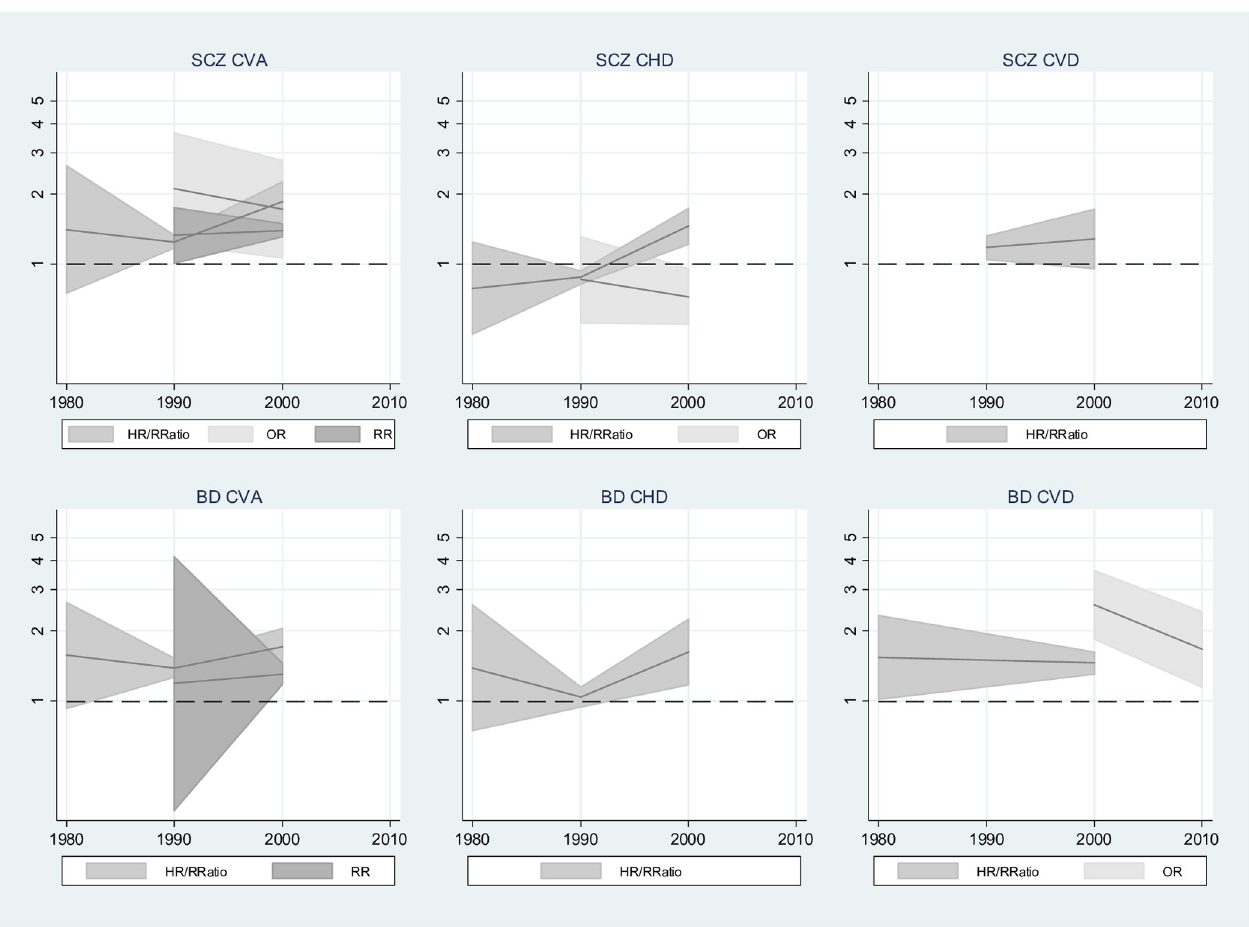
Fig 5. Trend in risk of CVD incidence for SMI compared with control participants, by median decade. BD, bipolar disorder; CHD, coronary heart disease; CI, confidence interval; CVA, cerebrovascular accident; CVD, major cardiovascular events; HR, hazard ratio; OR, odds ratio; RR, risk ratio; RRatio, rate ratio; SCZ, schizophrenia; SMI, severe mental illness. y-Axes show estimated risks on log scale, and shaded areas show 95% CIs for risk